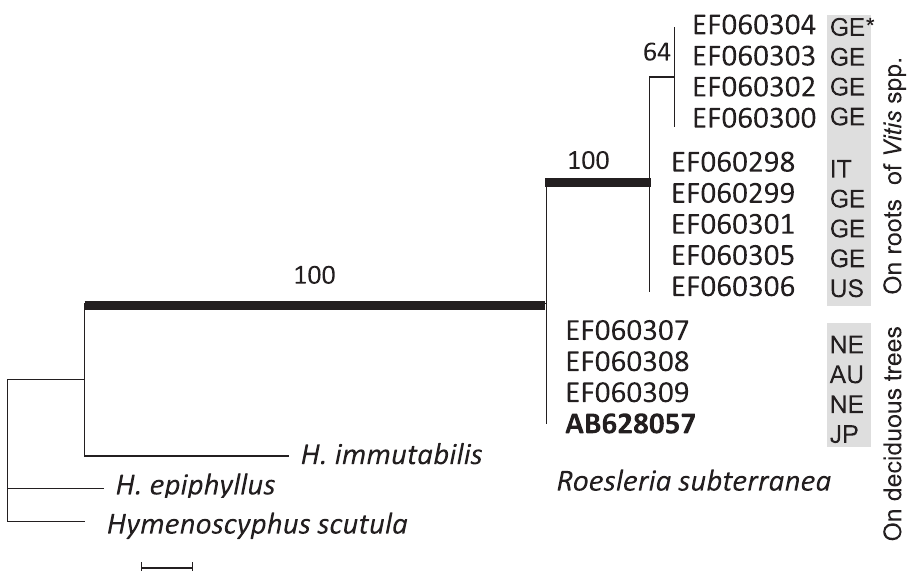
Figure 2. A single most parsimonious tree of Roesleria subterranea (ITS-5.8S sequences). Tree length = 31, CI = 0.8065, HI = 0.1935, RI = 0.8723, RC = 0.7035. The tree was constructed from a dataset of all avail- able ITS-5.8S sequences of R. subterranea from various hosts and localities. The numbers on the branches indicate the bootstrap values (BP) of 1000 replications in maximum parsimony analysis when the BP exceeds 50%. The scale bar indicates the number of substitutions. Abbreviations indicate the localities of the isolates: AU, Austria; GE, German; IT, Italy; NE, Netherlands; US, USA; JP,